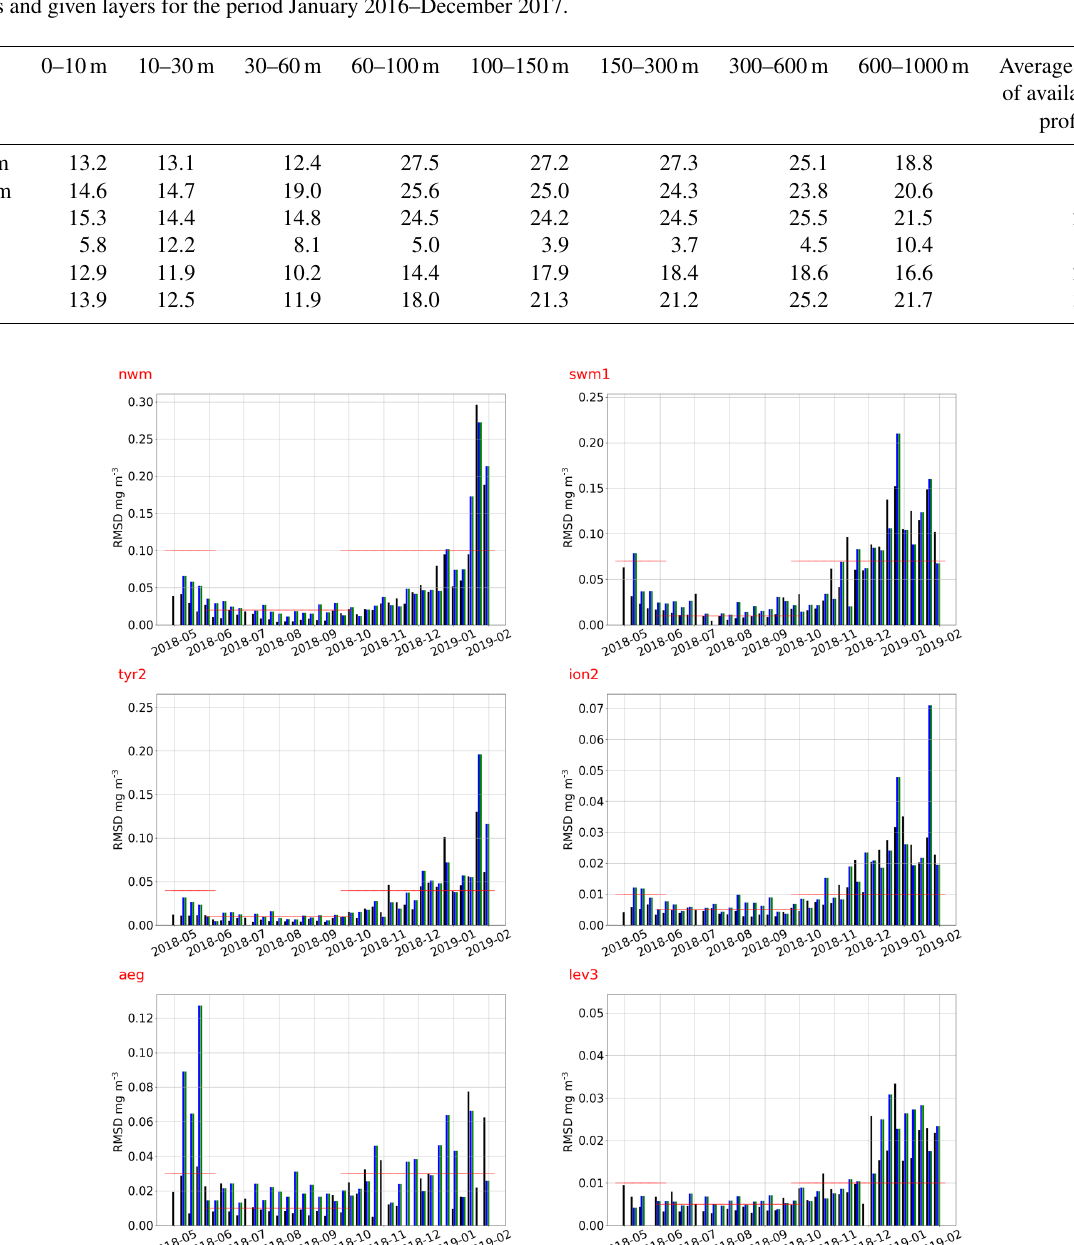
Table 5. RMSD of the oxygen difference between BGC-Argo float and model at the float position and time. Statistics are computed for